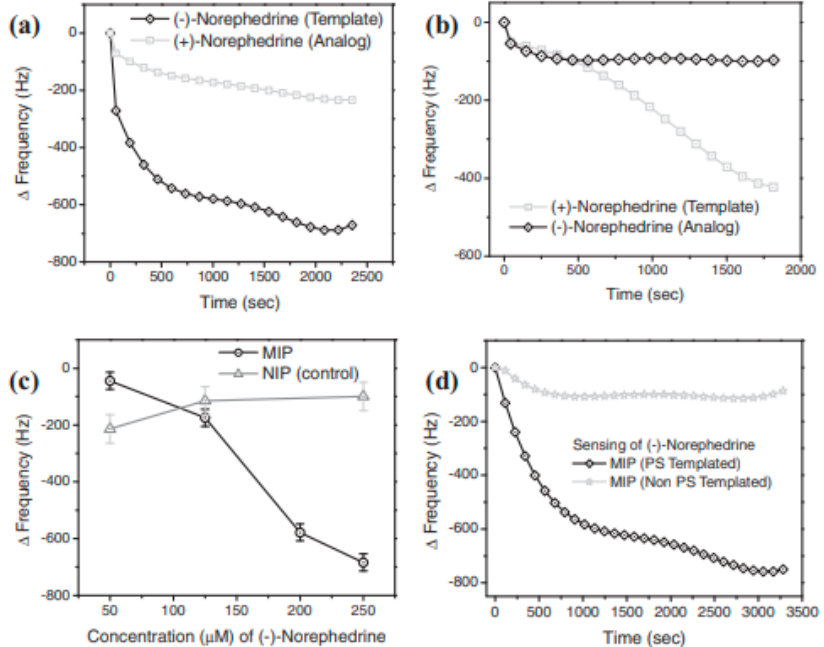
Figure 6. QCM sensing of 250 μ M concentration of ( a ) ( − )-norephedrine, ( b ) (+)-norephedrine, ( c ) ( − )-norephedrine sensing calibration plot of the MIP film versus the NIP (control) and ( d ) comparison of the sensing response of the PS and non-PS-templated MIP film. Reprinted with permission from reference [58]. Copyright 2012 Wiley.